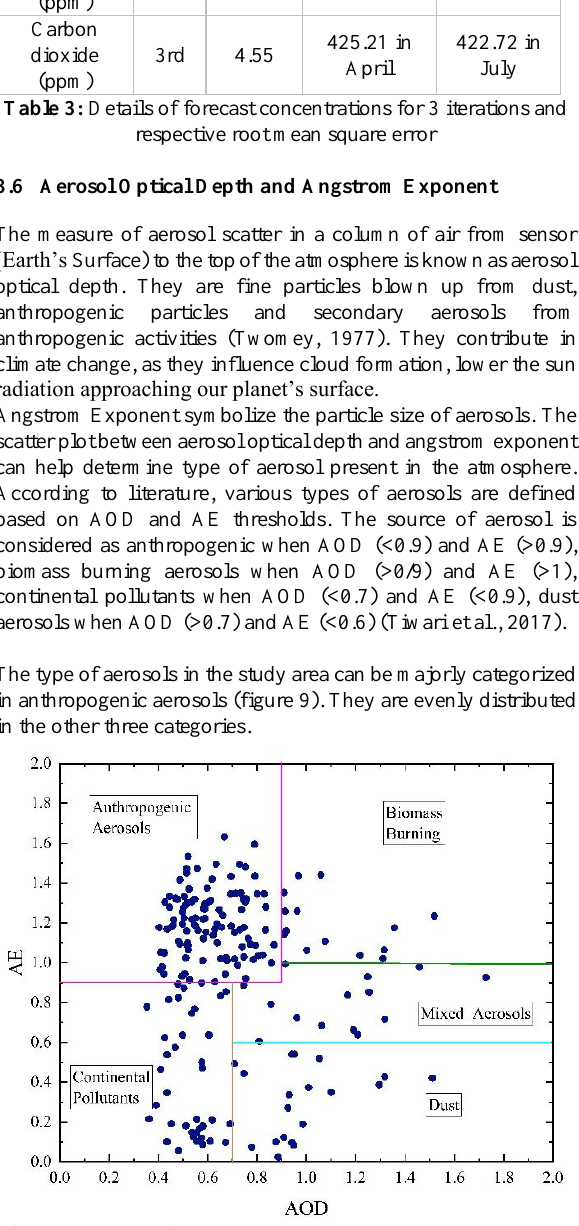
Figure 9: Types of aerosols present in Punjab region based on optical depth during